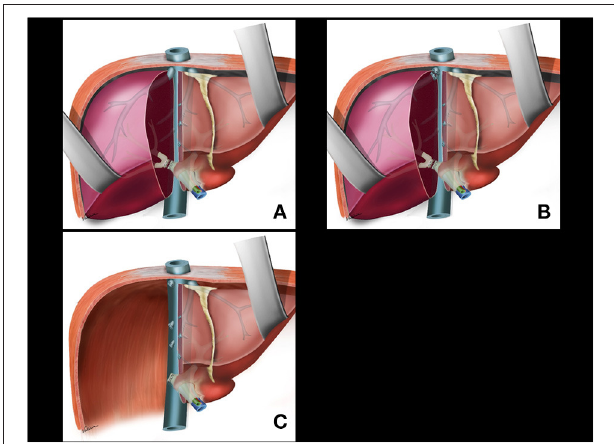
FIGURE 5 | (A) Division of the right pedicle. (B) Right hepatic vein and right accessory veins transection. (C) Last step of the surgery is to release the liver from the right aspect of cava vein, right ligaments, adrenal gland, and diaphragm including tumor adhesions if